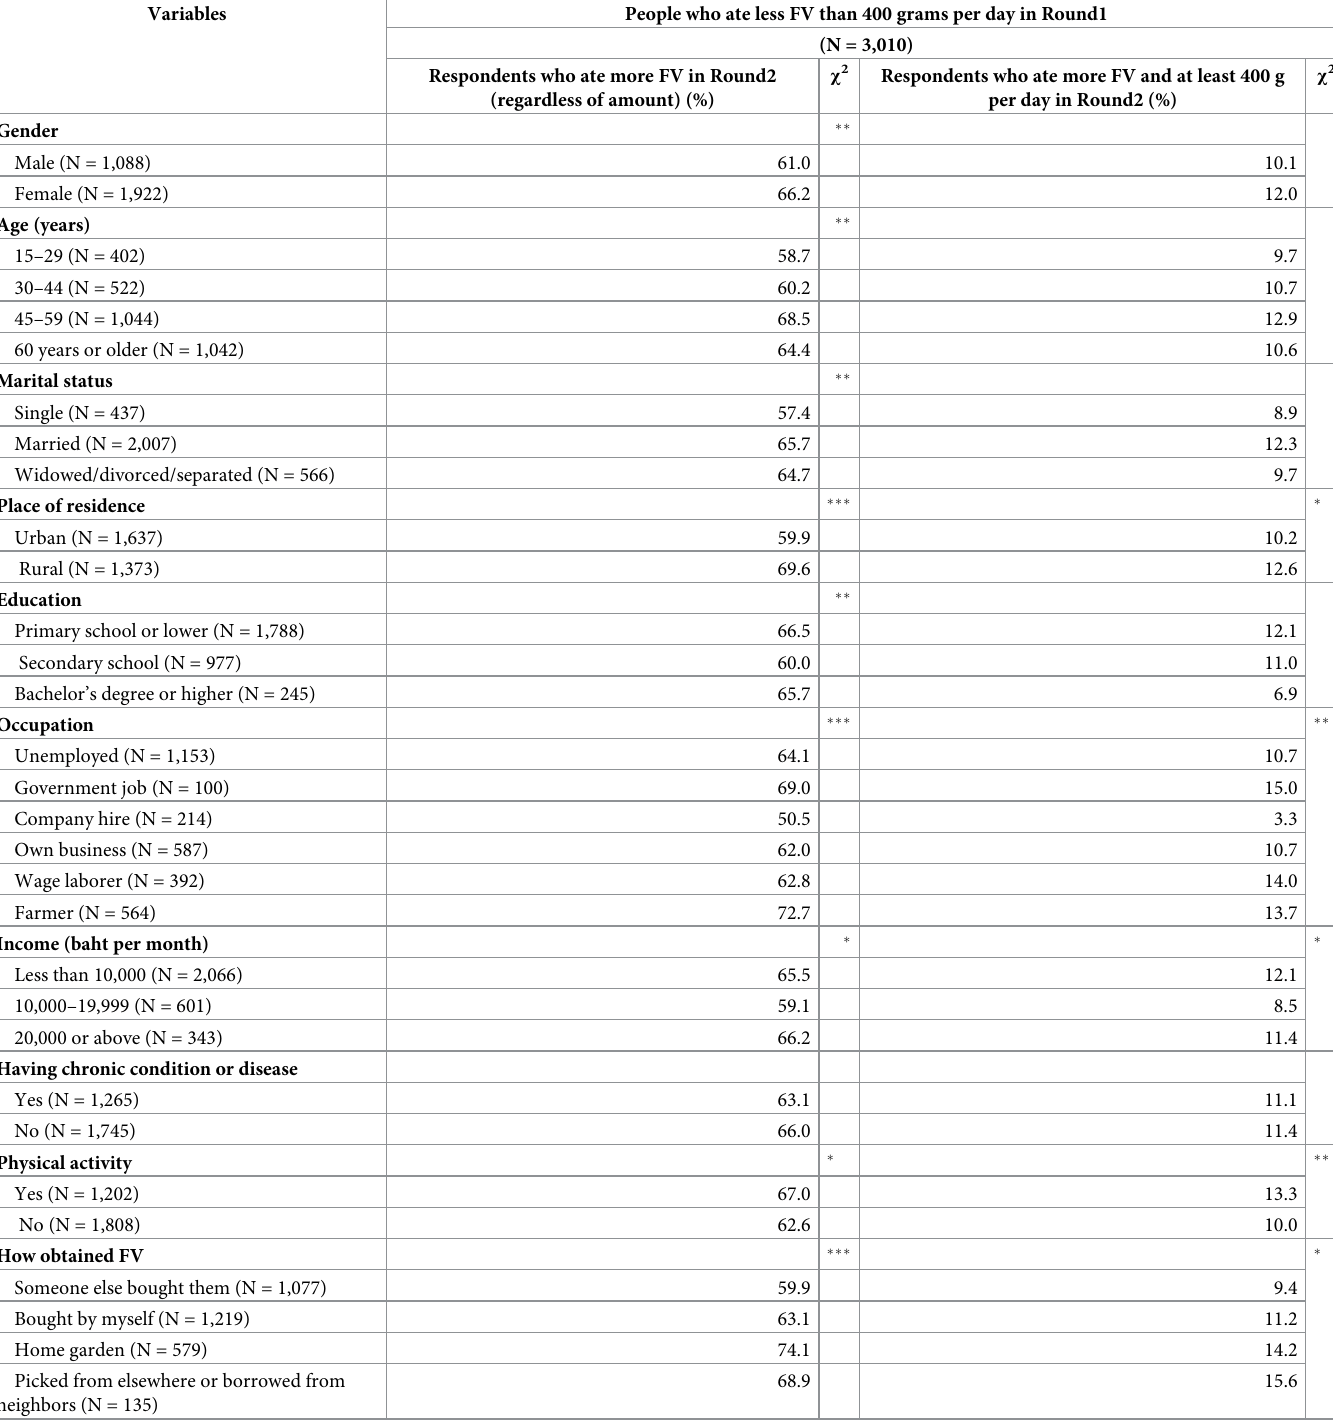
Table 3. Chi-square test of association between exposure to FV campaigns and other factors, and changes in FV consumption.